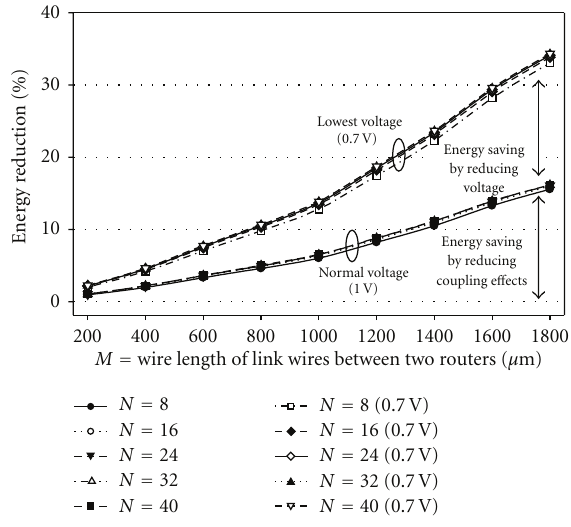
Figure 17: Energy reduction under di ff erent lengths of link wires and di ff erent number of routers.